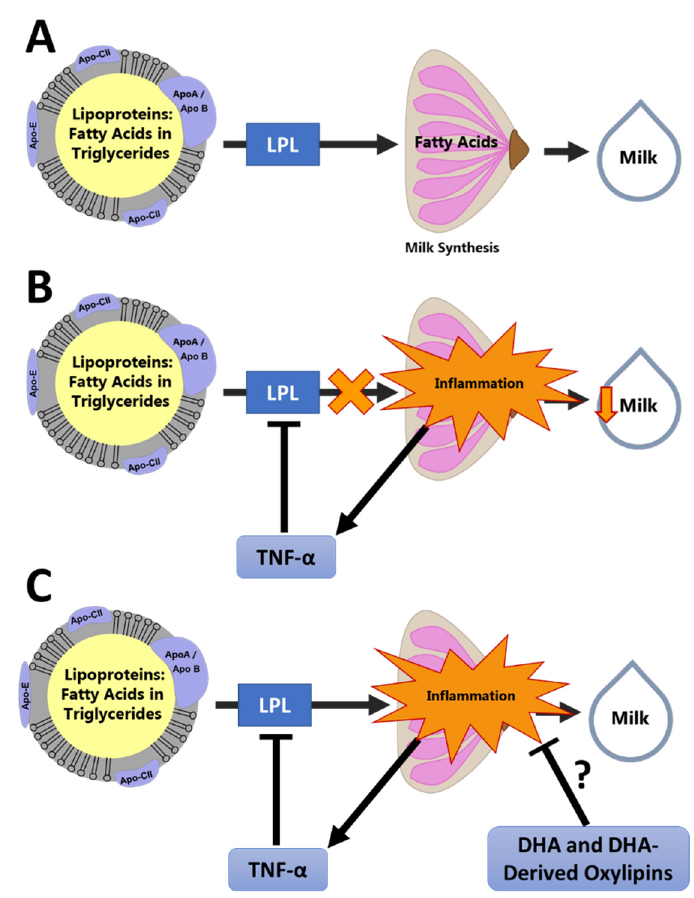
Figure 1. Conceptual Model of the Effect of Inflammation on Milk Production. This conceptual framework illustrates how oxylipins may be involved in resolution of mammary inflammation, leading to improved milk synthesis: ( A ) Fatty acids are oxidized by the mammary gland for energy and used as substrate for synthesis of the milk fat globule. This process requires uptake of fatty acids from the circulating lipoproteins by LPL. ( B ) Inflammation causes suppression of LPL by TNF- α , reducing fatty acid availability in the mammary gland and reducing milk synthesis. ( C )